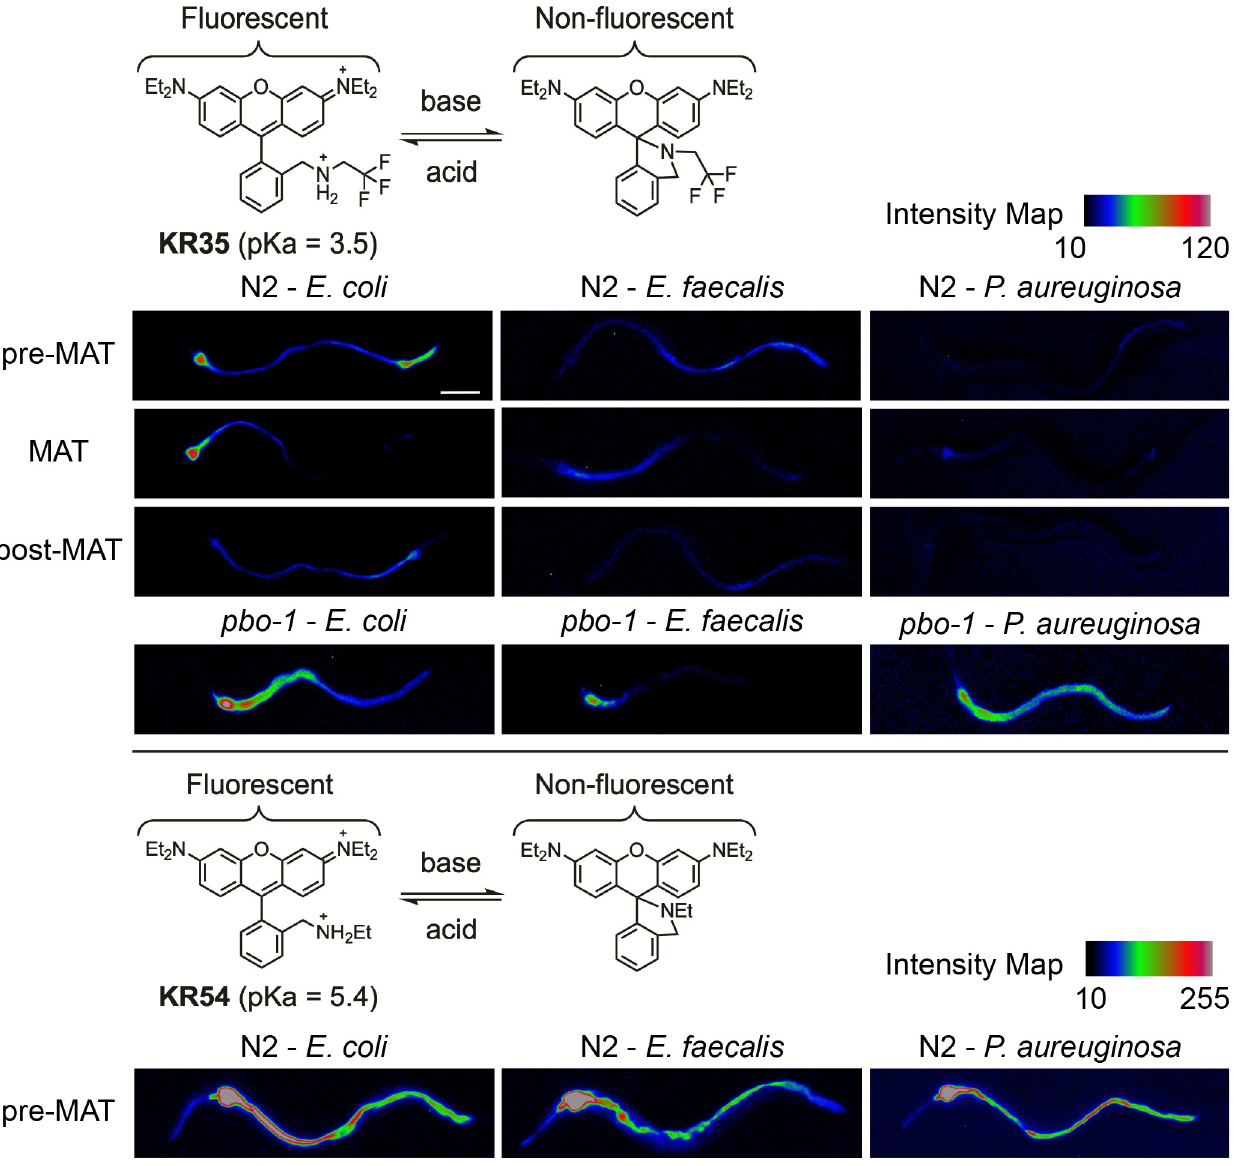
Fig 4. Pathogens alter C . elegans intestinal pH. The chemical structures of KR35 and KR54 under acidic and basic conditions are shown. The protonated ring-opened form is highly fluorescent, and the deprotonated spirocyclic form is non-fluorescent. Fluorescence micrographs of C . elegans wild type or pbo- 1 mutant fed E . coli or pathogen ( E . faecalis or P . aeruginosa ), followed by administration of KR35 (10 μ M) for 30 min or KR54 (10 μ M) for 10 minutes. Time-dependent images during the DMP extracted from video microscopy are shown. Fluorescence is rendered as a heat map of fluorescence intensity with red representing the most intense fluorescence (high acidity), and black the least intense fluorescence (low acidity) and the map of the intensity values is shown for each fluorophore. The head of the animal is on the left side of each image. (scale bar = 50 μ m).